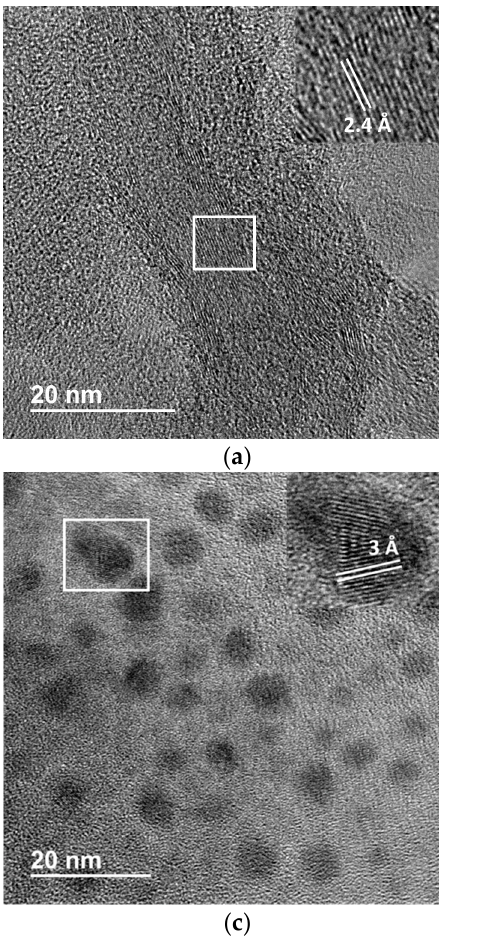
Figure 4. ( a ) HR-TEM image showing the typical layer size of the bare graphene used. ( b ) FESEM image showing the surface of the bare graphene. ( c ) HR-TEM image showing an example of the lead halide nanocrystals synthesized (MAPbBr 2.5 I 0.5 ), with interplanar distance of 3 Angstrom. ( d ) Example of FESEM image obtained via back-scattered electron (BSE) detector for MAPbBr 3 . The black background corresponds to graphene, while bright spots denote the presence of perovskite nanocrystals.